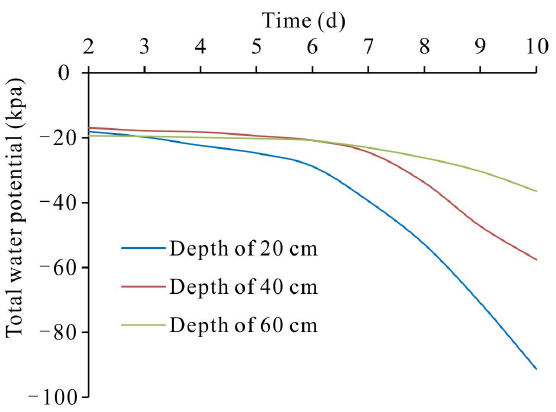
Figure 16. Changes in total water potential at di ff erent depths in the non-control zone.